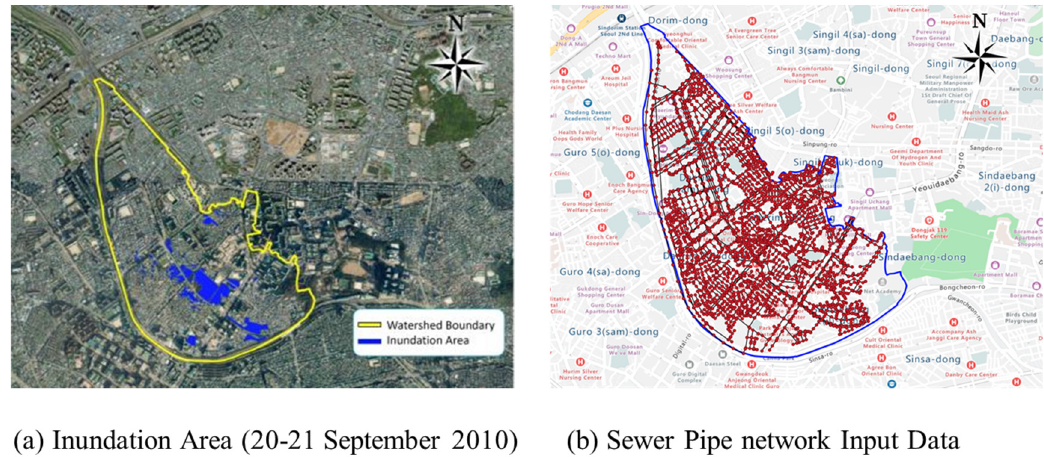
Figure 9. GIS map of the Dorim 1 watershed.